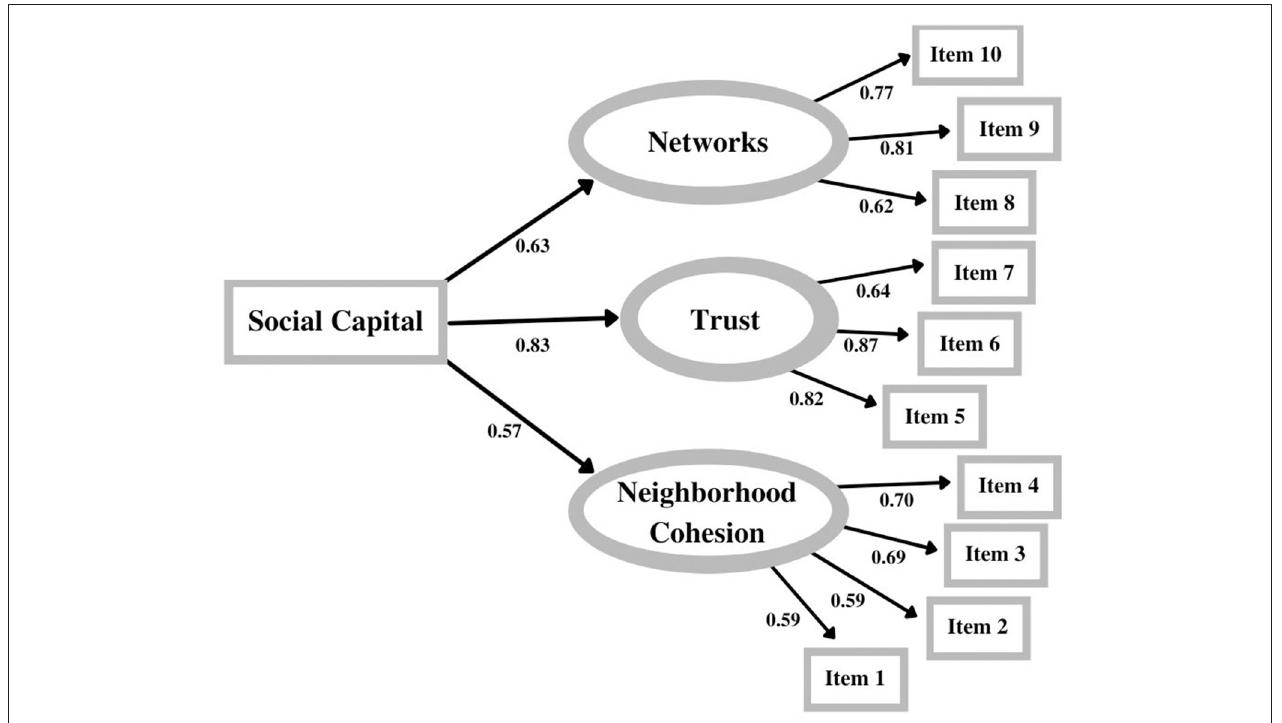
FIGURE 2 | Social capital latent